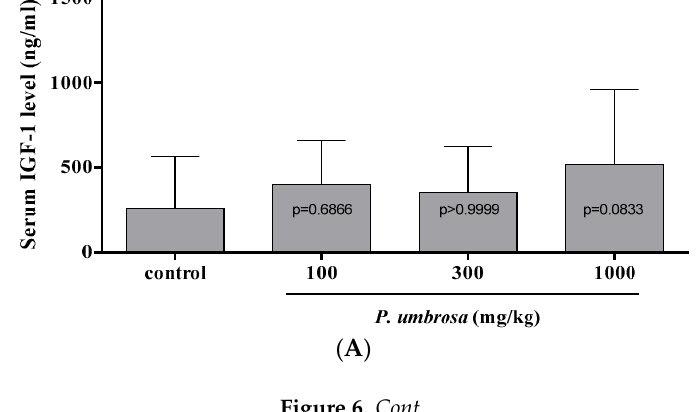
Figure 6. Cont . Figure 6. Cont